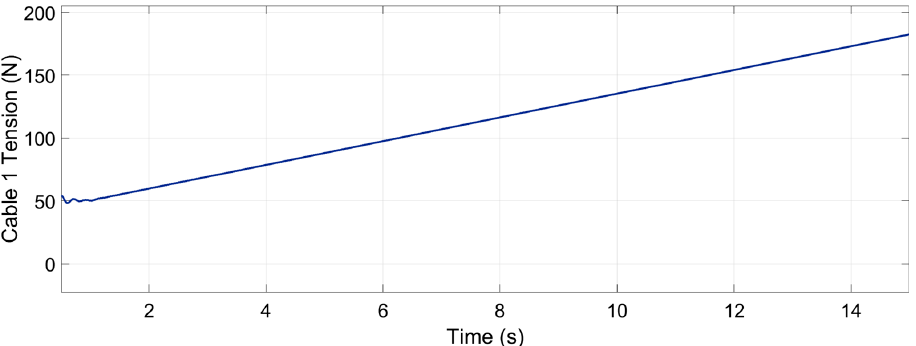
Figure 19. Tension in cable 1—from 50 N to 182.4 N.